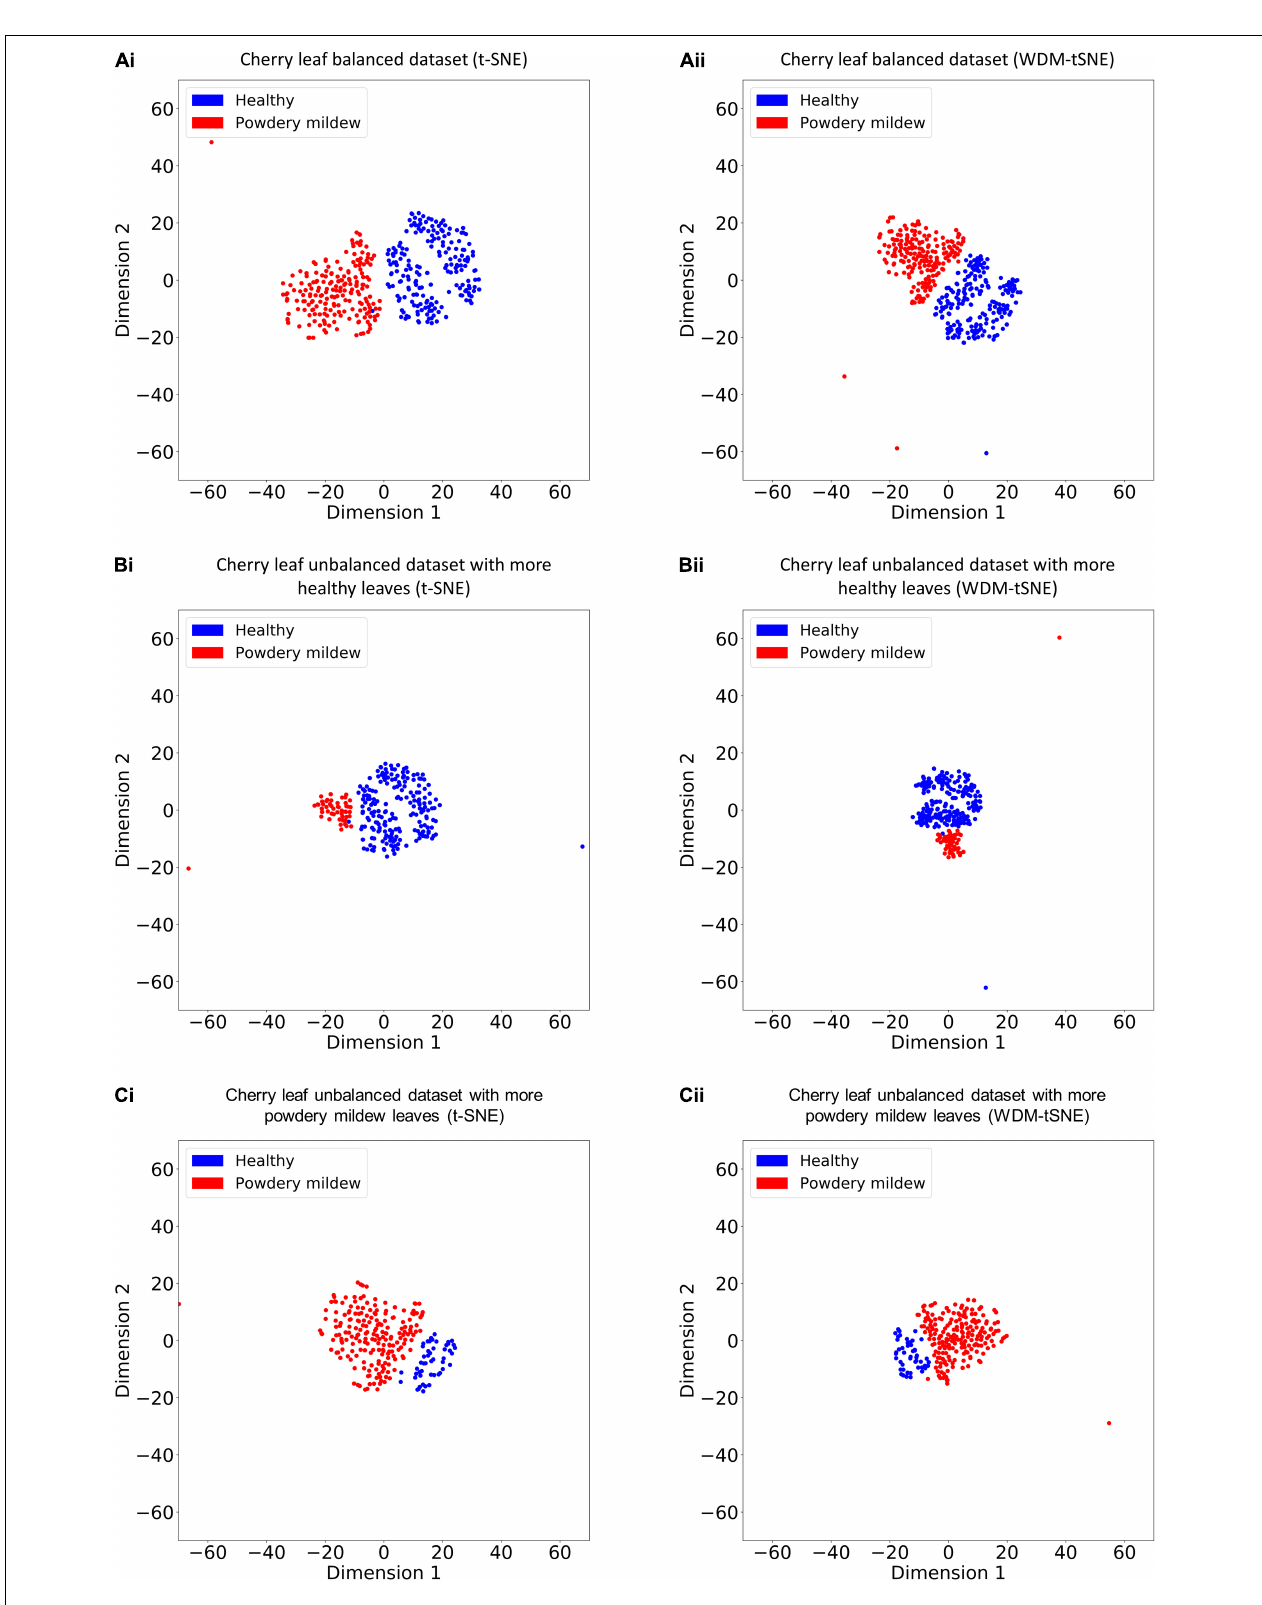
FIGURE 7 | The plots for the (A) balanced and (B–C) unbalanced datasets of the cherry leaf with powdery mildew based on (i) t-SNE and (ii) WDM-tSNE. WDM-tSNE, Weighted Distance Metric and the t-stochastic neighbor embedding algorithm.